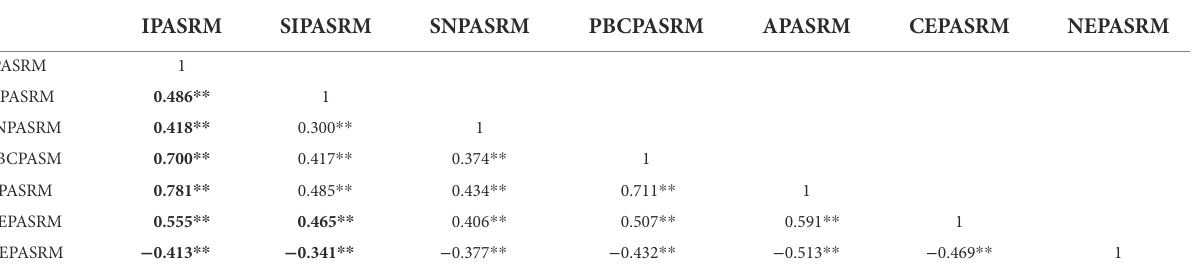
TABLE 2 Correlation matrix of the study